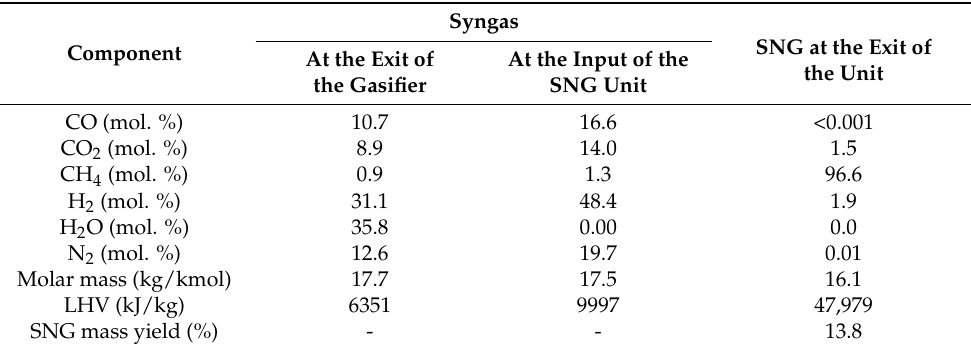
Table 3. Molar composition of the syngas and